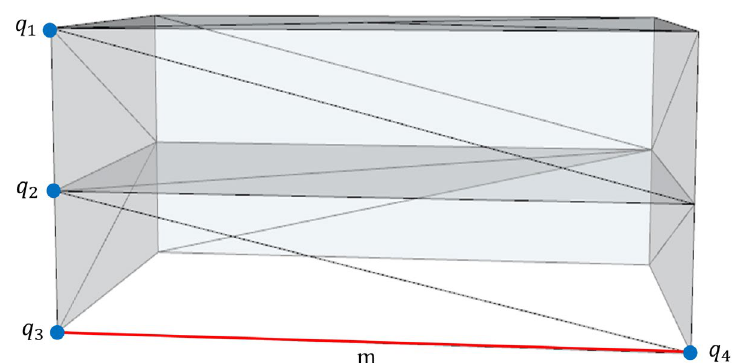
Figure 6. Hole vertices of building models ( m is the hole edge, q 3 and q 4 are the hole vertex, and q 1 and q 2 are the ordinary vertex).